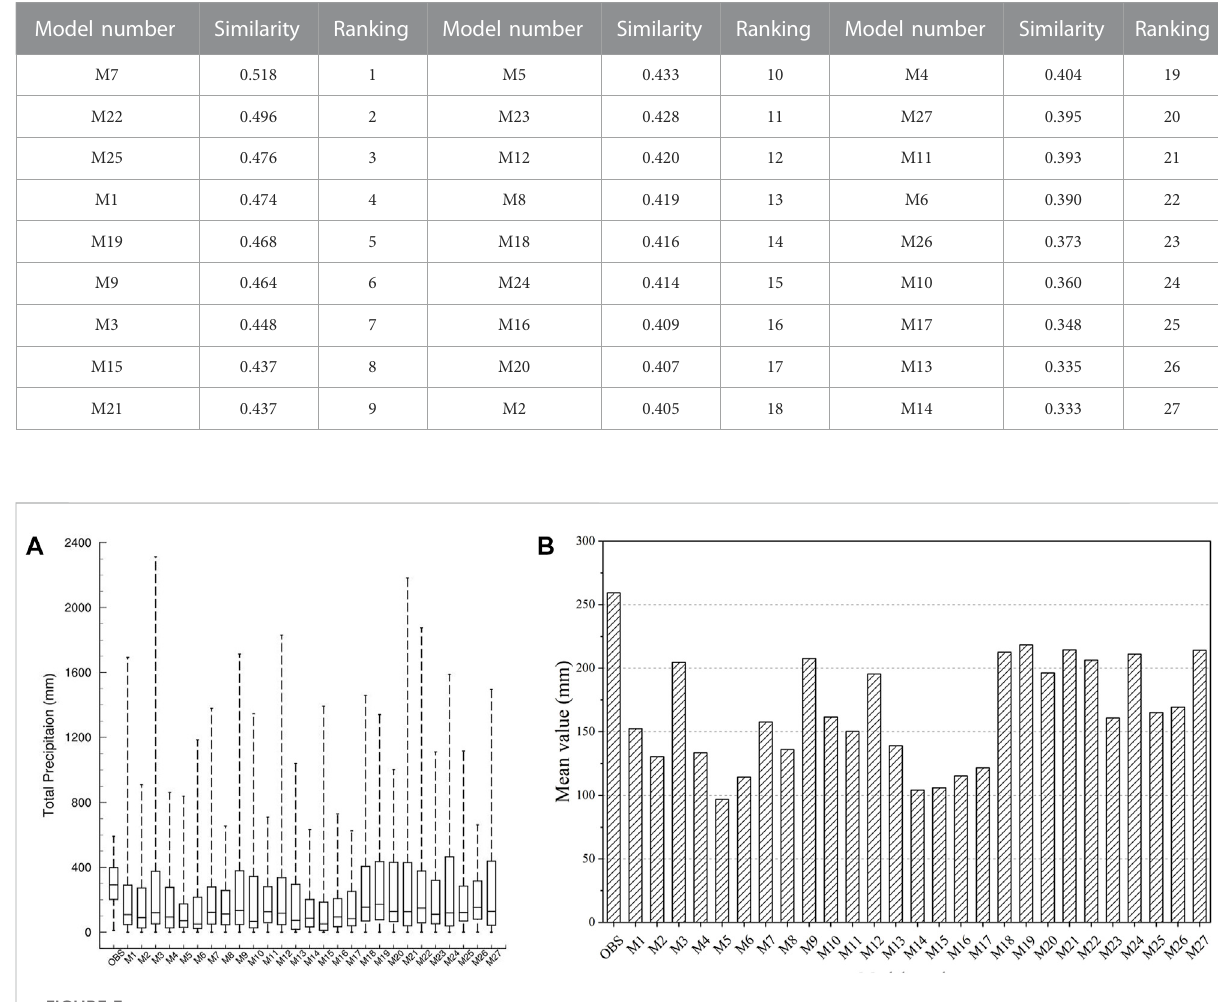
TABLE 5 Similarity by Euclidean distance for WRF combination members.